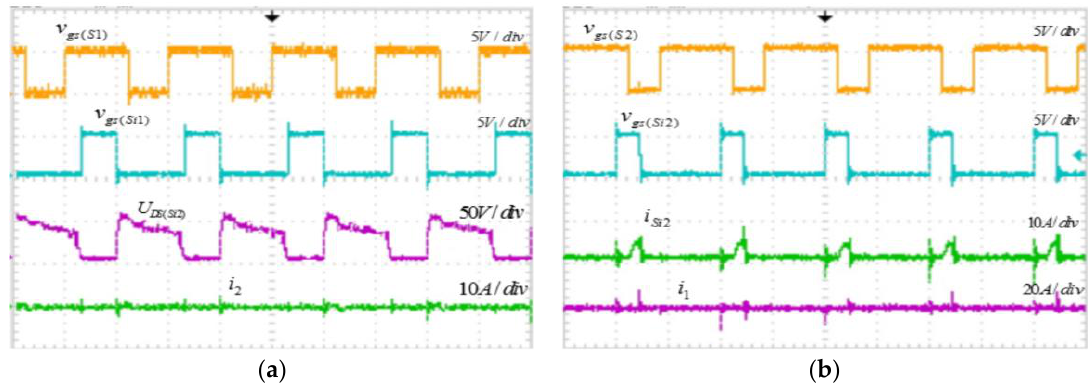
Figure 14. Experimental results for the isolated high conversion ratio operation mode: ( a ) step-up converter; and ( b ) step-down converter.